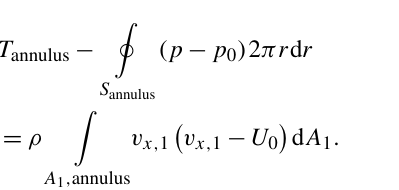
Figure 7. The Joukowsky momentum theory results compared with potential flow calculations.